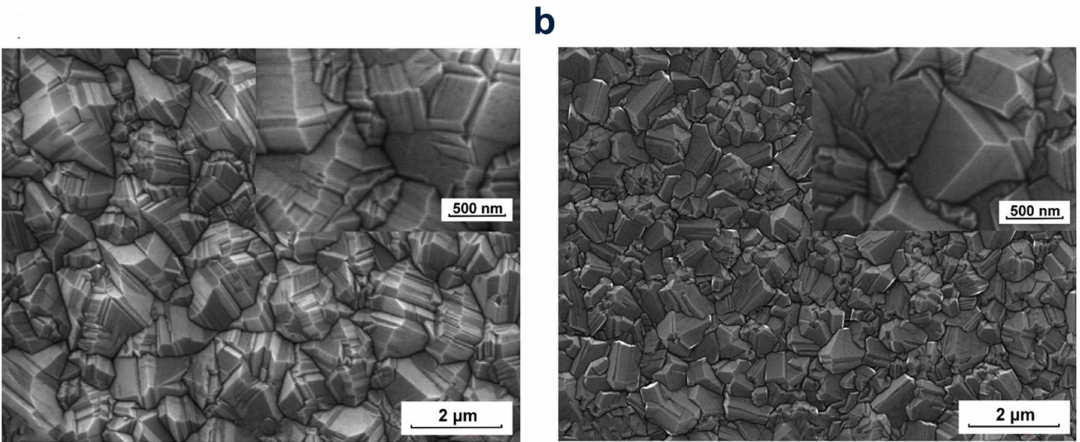
Figure 8. SEM micrographs of the diamond layers made of various craft gas